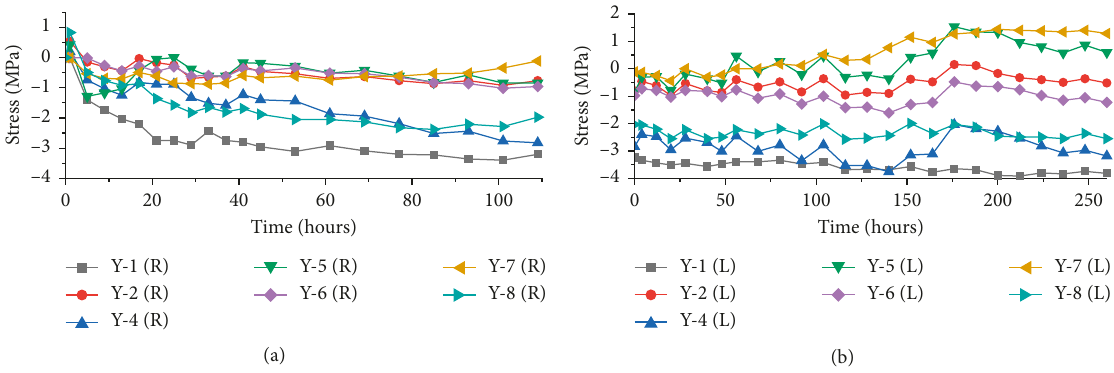
Figure 12: Stress time history curves of secondary lining of right tunnel: (a) after the excavation of the right tunnel tube; (b) after the excavation of the left tunnel tube.